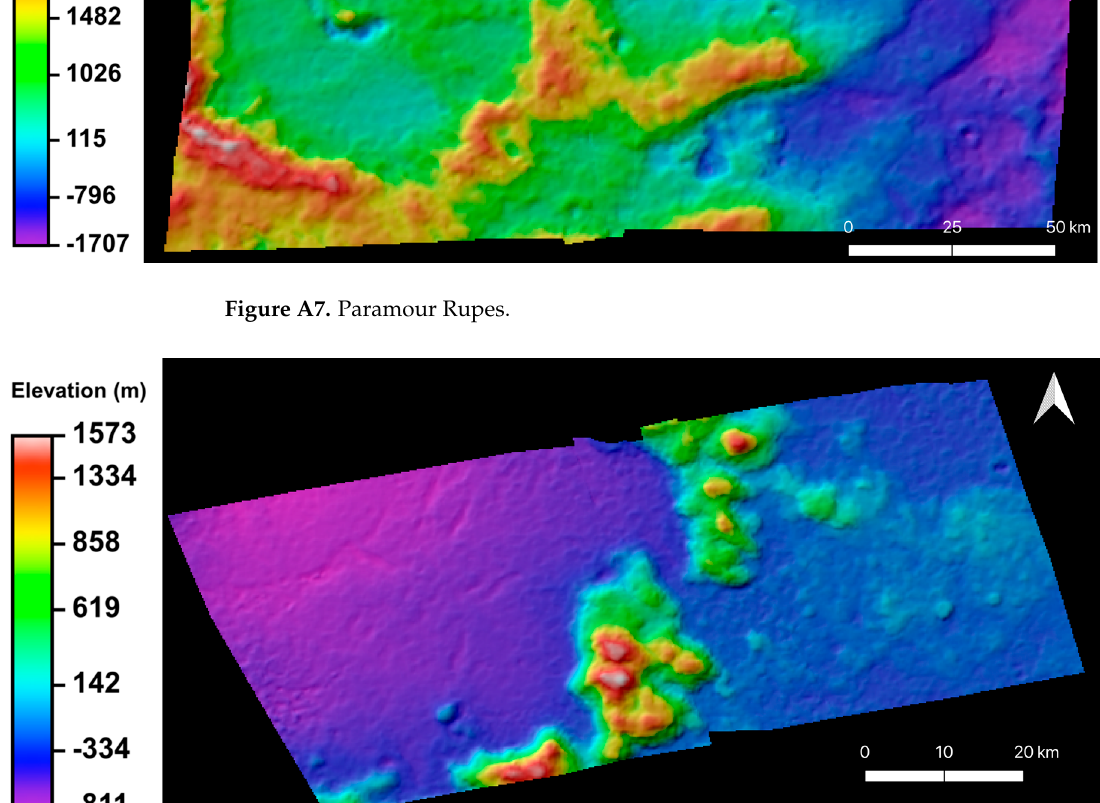
Figure A8. Hollows in Raditladi Basin.